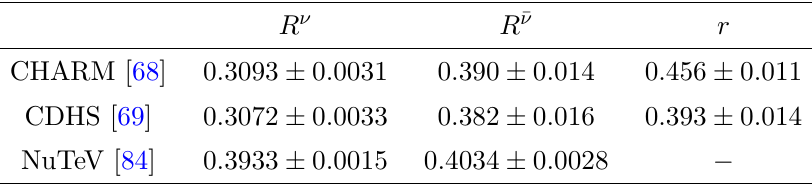
Table 3 . Values of the neutral to charged current cross section ratios R ν and R ¯ ν reported by the different experiments. The CHARM and CDHS collaborations also report a value for the ratio r defined in eq. (3.13). The numbers shown for the NuTeV experiment are extracted from ref. [84] (see text for